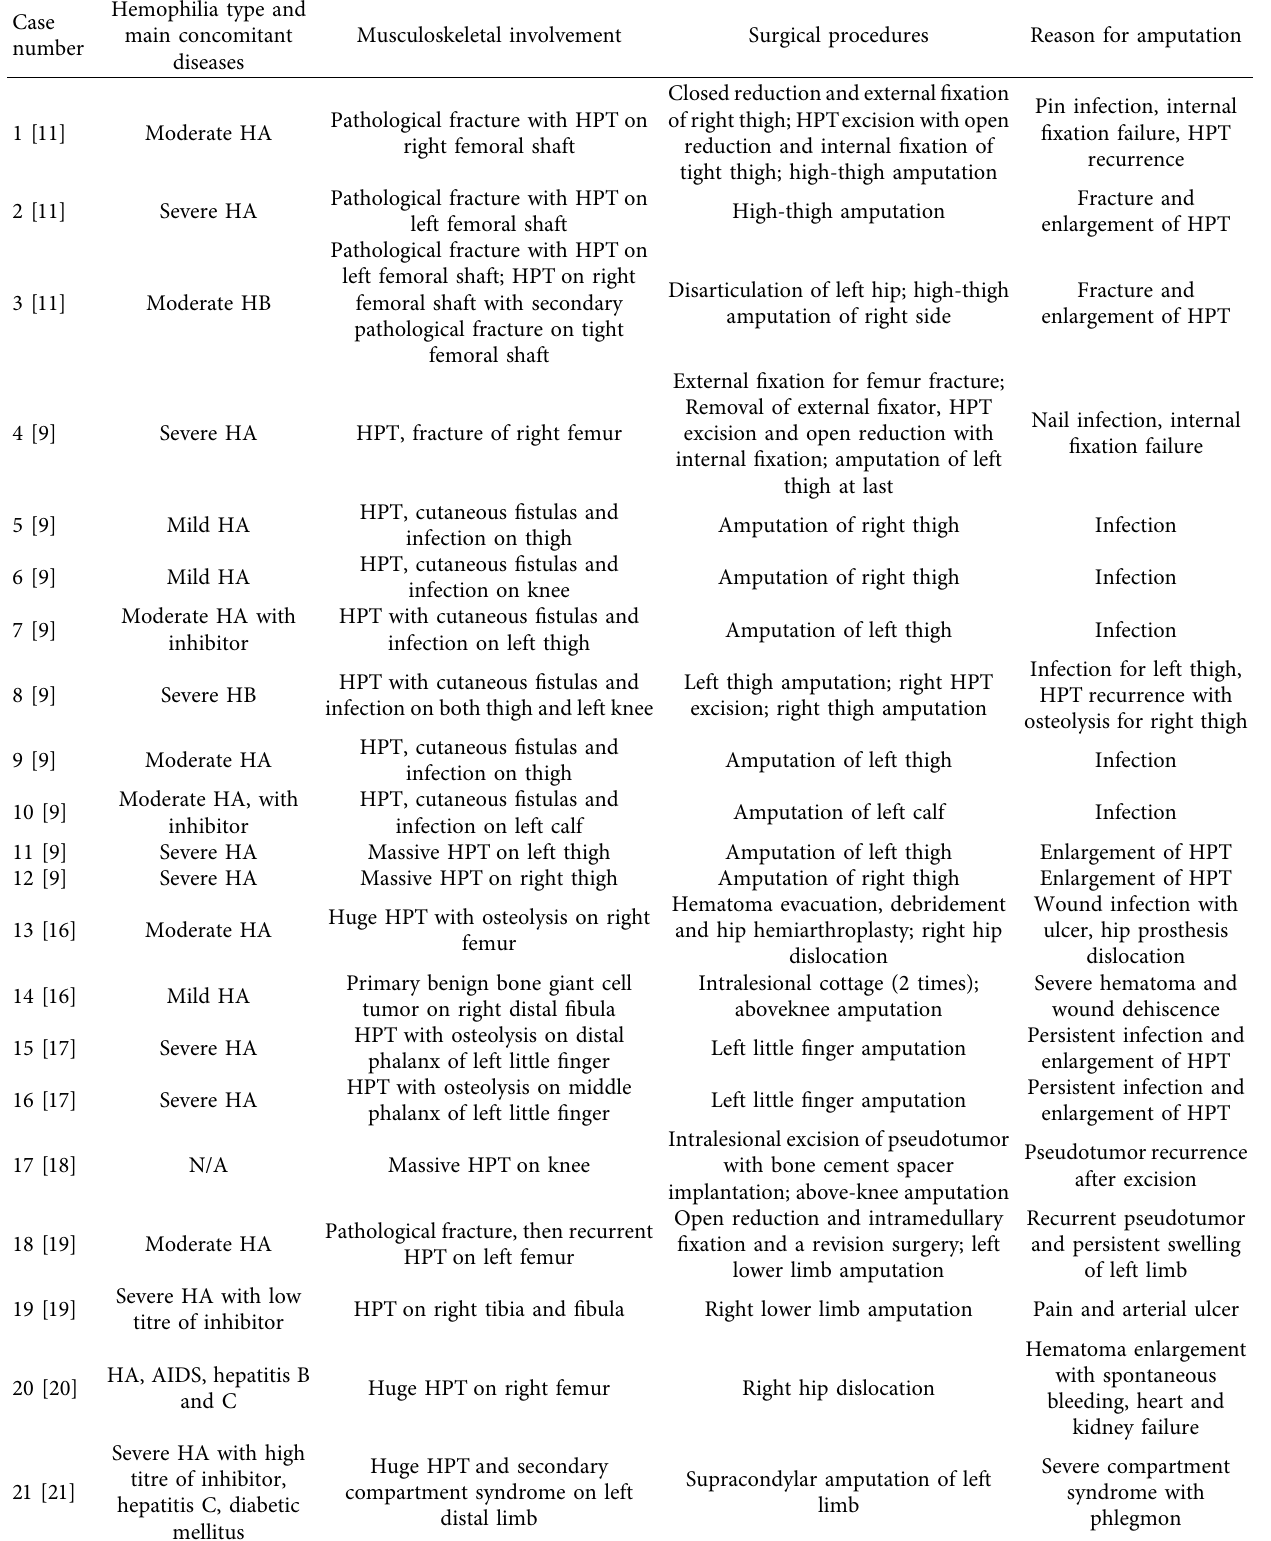
Table 3: Previous reported amputation